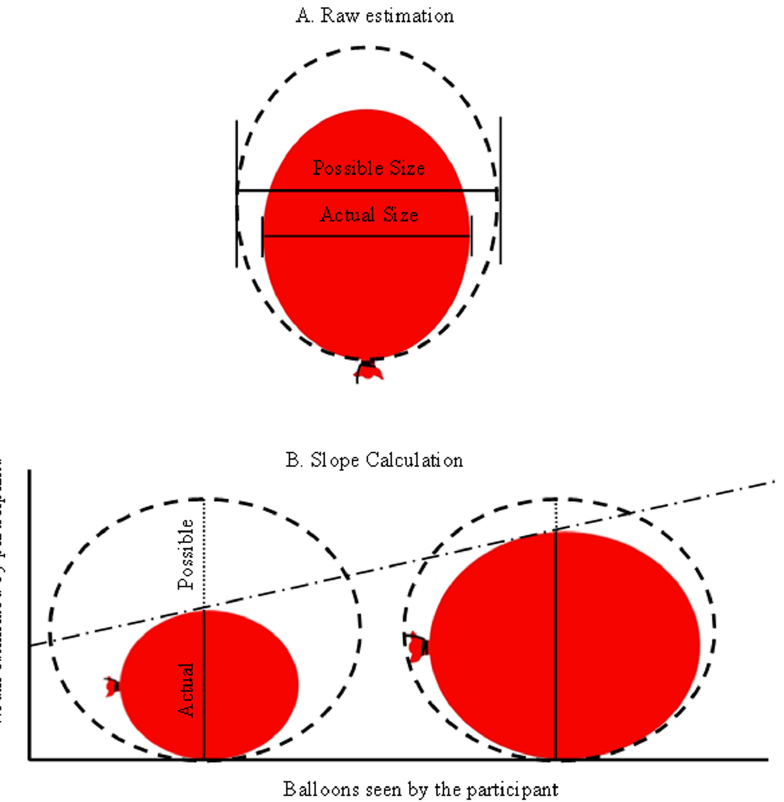
Figure 1. Graphical depictions of the calculations. ( A ) Participants made estimations about the actual size of each particular balloon and how big it could become before popping. These estimations provide a measure of both real-world perception and the subjective point of risk (i.e., popping for balloons) for each participant. ( B ) We calculated the slope changes based upon the estimations reported by each participant. The actual balloons varied in size (either 4, 5, 6, 7, or 8 inches wide), and we plotted these actual sizes against the estimated sizes reported by the participant. Note that actual sizes should show a linear increase of 1 if the participant reported actual sizes with perfect accuracy, whereas additional size estimates should show a linear decrease of -1 if the participant reported additional sizes with perfect